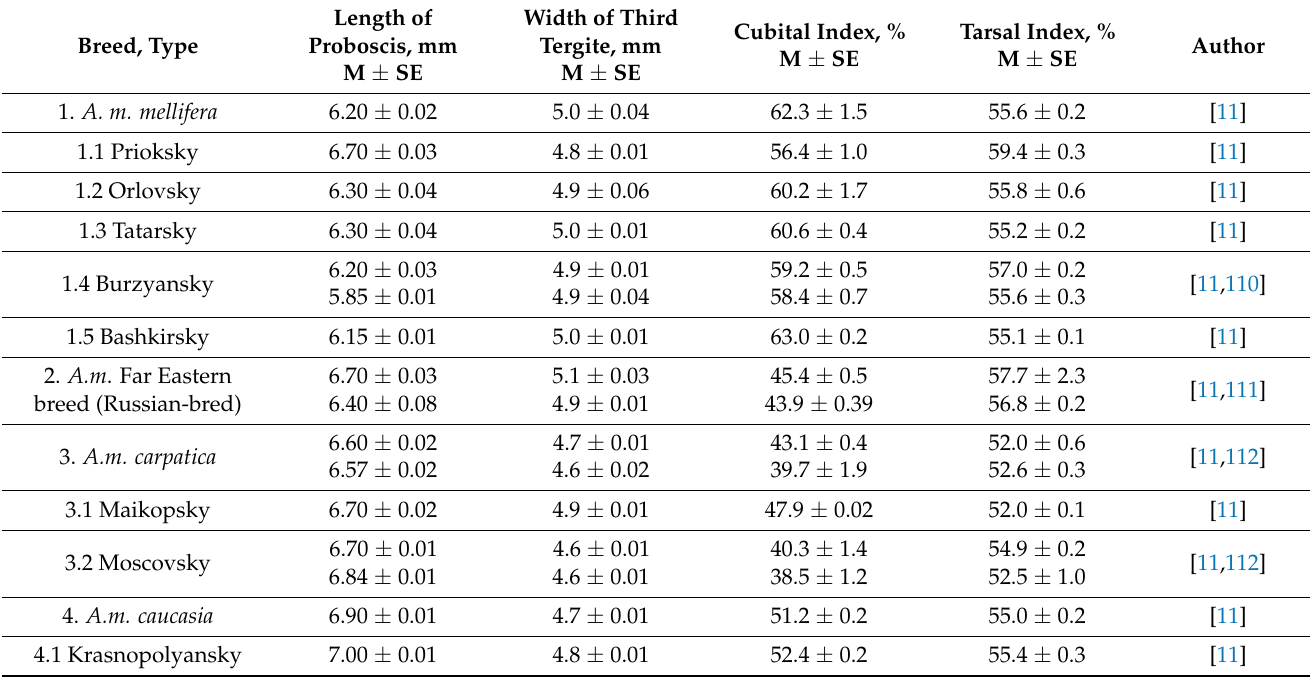
Table 1. Morphometric characteristics of A. mellifera L. worker bees from four breeds and eight bee types.